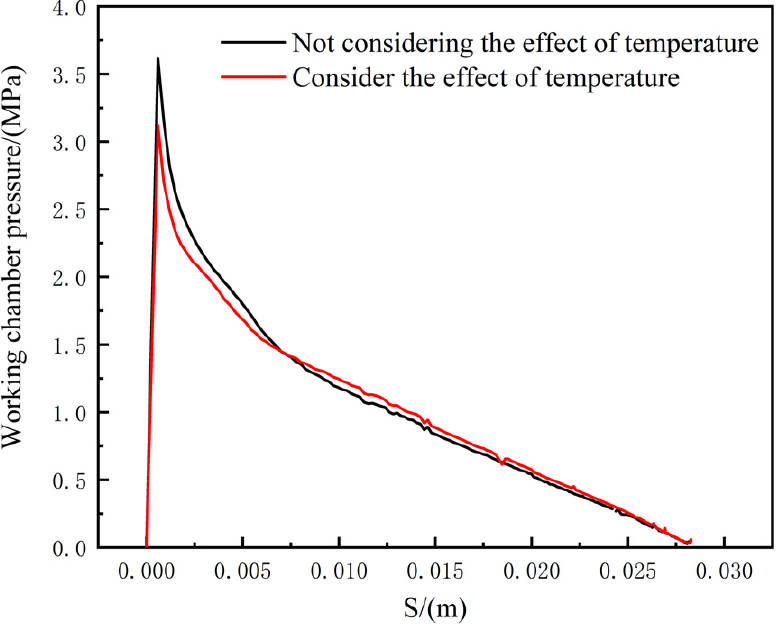
Figure 16. Curves of working chamber pressure and piston stroke considering the viscosity–temperature characteristics of magnetorheological fluids.